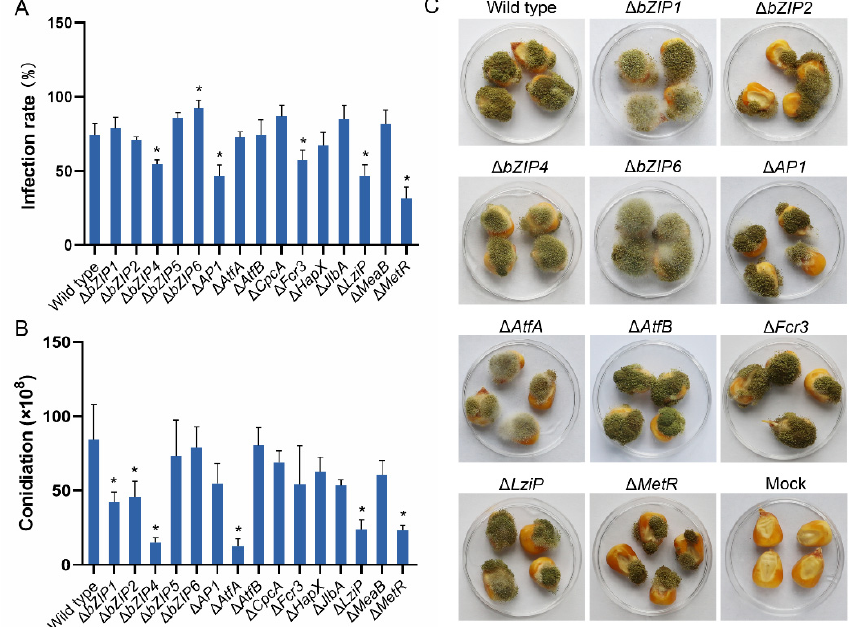
Figure 10. Pathogenicity assay of the Aspergillus flavus strains. Maize kernels were inoculated with a conidial suspension for 7 days. ( A ) Infection rate (%) of mutants. The rate of infection was calculated by taking the infected areas and dividing them by the surface areas of the kernels. ( B ) Conidial production of the mutants colonized on kernels. The conidia of mutants were harvested by washing the kernels with 0.01% Triton X-100 and then numbered. Error bars represent the SD. ( C ) Virulence assay of 10 mutants on maize kernels. The 10 mutants ∆ bZIP1 , ∆ bZIP2 , ∆ bZIP4 , ∆ bZIP6 , ∆ AP1 , ∆ AtfA , ∆ AtfB , ∆ Fcr3 , ∆ LziP and ∆ MetR differed significantly in infection rate or/and conidial production compared with the wild type. Bar = 0.5 cm. * p < 0.05, significant difference from the wild-type group as estimated by a Dunnett test. SD, standard deviation.